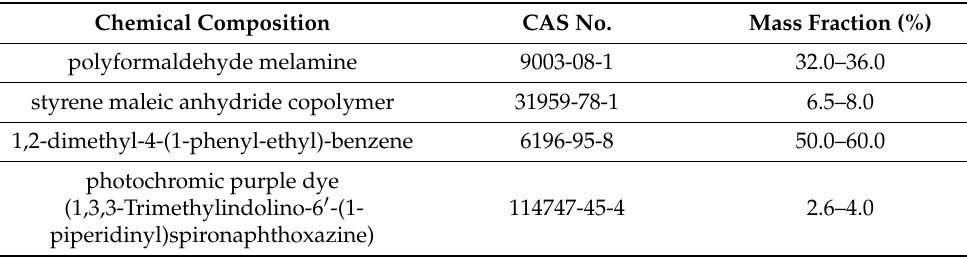
Figure 1. Macroscopic morphology of the photochromic microcapsules: ( A ) before photochromism, ( B ) after photochromism. Table 2. List of experimental materials. Table 3. Components of the photochromic microcapsules.